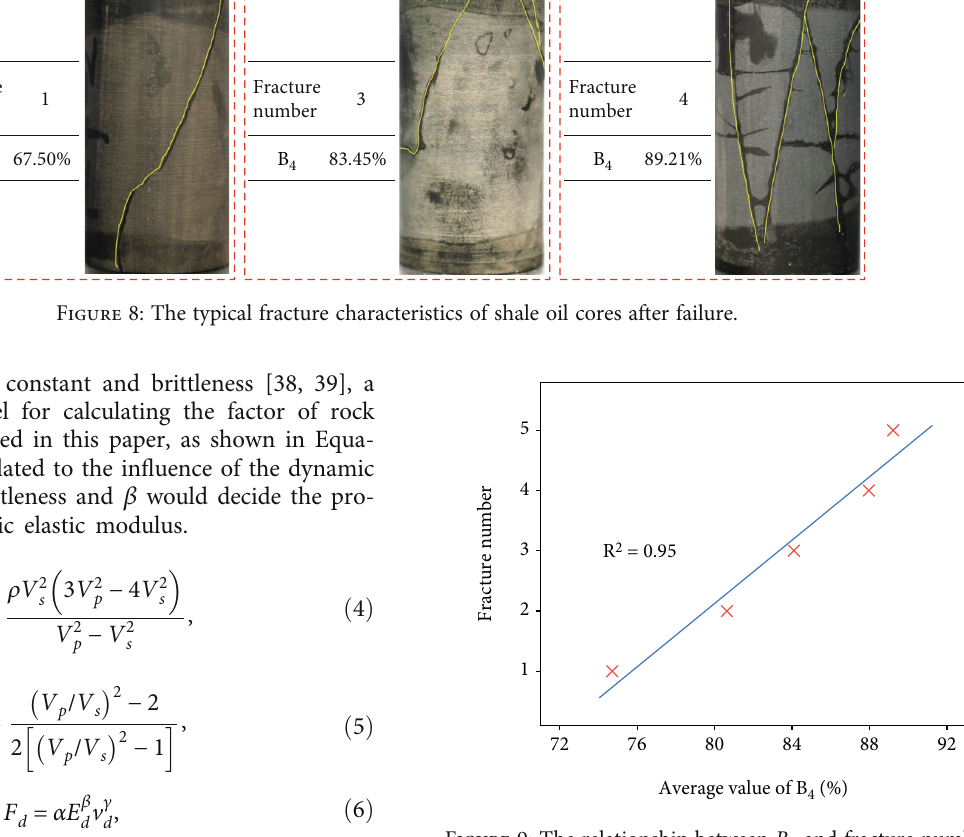
4 and fracture number.